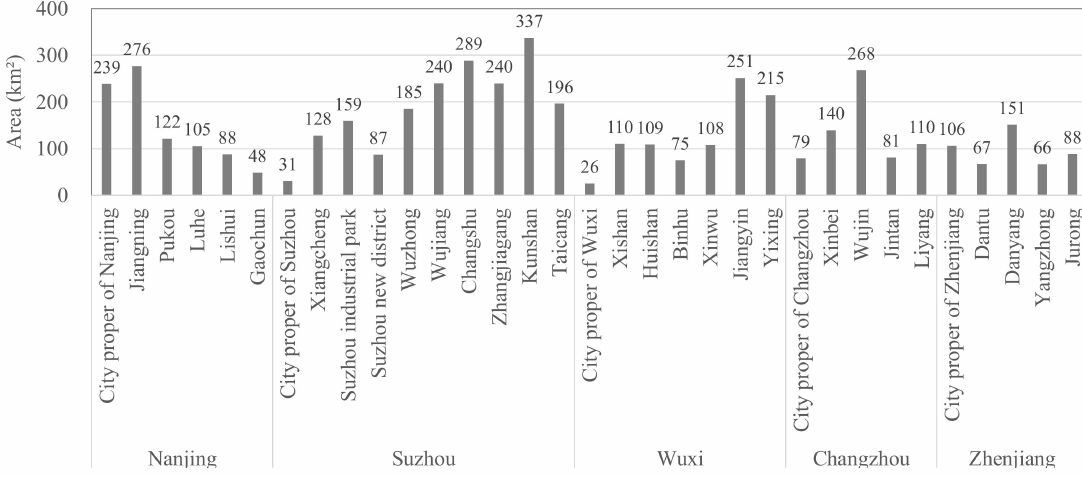
Figure 4. The expansion of construction lands in different units from 1990 to